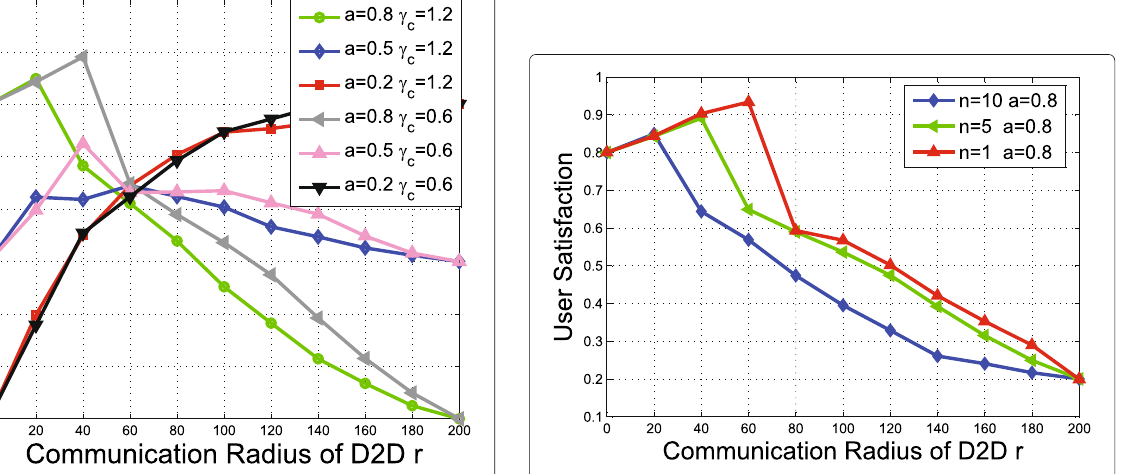
Fig. 11 The influence of γ c on user satisfaction under different weight with n = 5. This figure illustrates the effects of changing the popularity Zipf storage exponent γ c on user satisfaction with different coefficient a